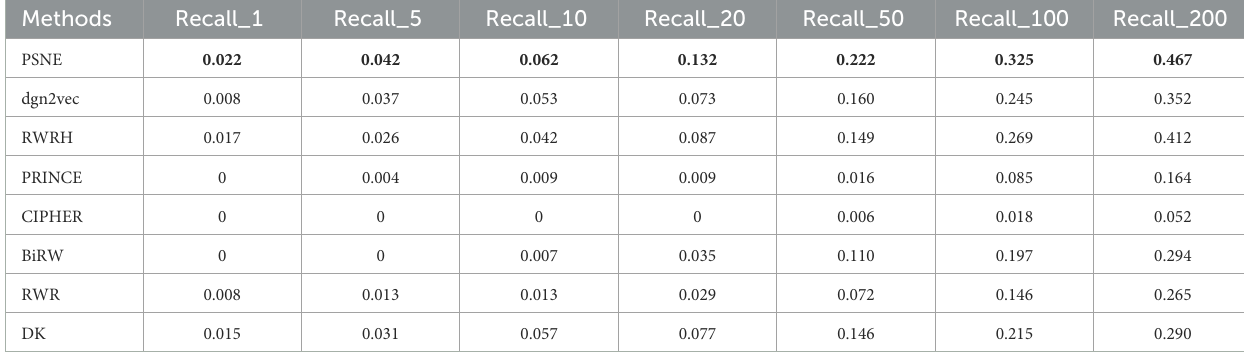
TABLE 2 For Alzheimer’s disease, the performance evaluation of PSNE in terms of top-k Recall (k = 1, 5, 10, 50, 100, and 200) with comparison to the state-of-the-art methods.